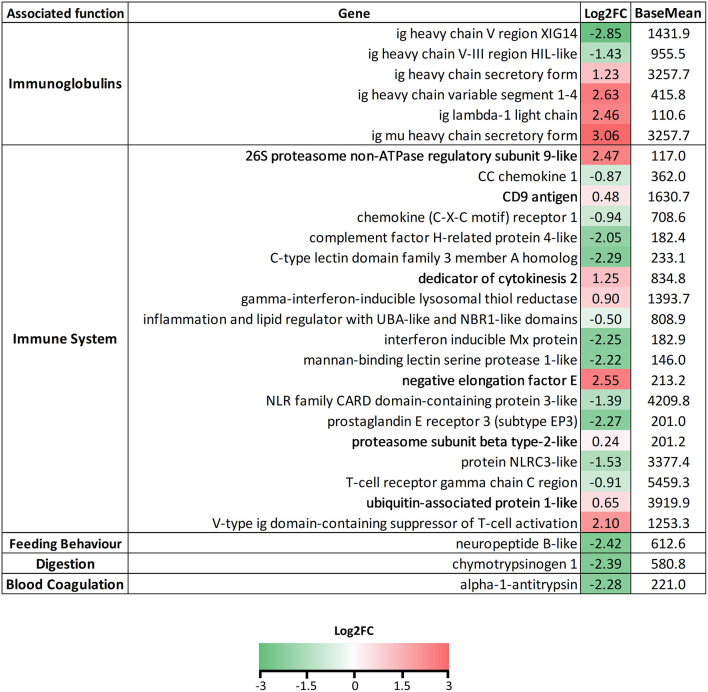
List of selected genes DE in the spleen samples of Ceratothoa-infected Dicentrarchus labrax. The genes were grouped in categories regarding their associated function. The numbers represent the Log2 fold change values and the color scale corresponds to −3-0-3 (green-white-red) Log2FC. BaseMean values represent the average of normalized counts divided by the size factor, taken over all samples.